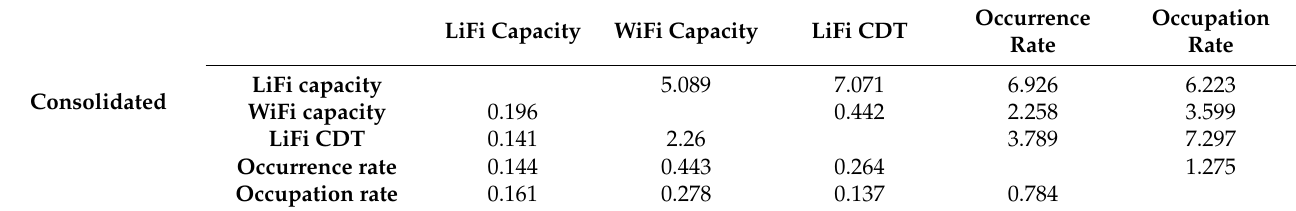
Table 18. CM of weighted geometric mean of all participants.